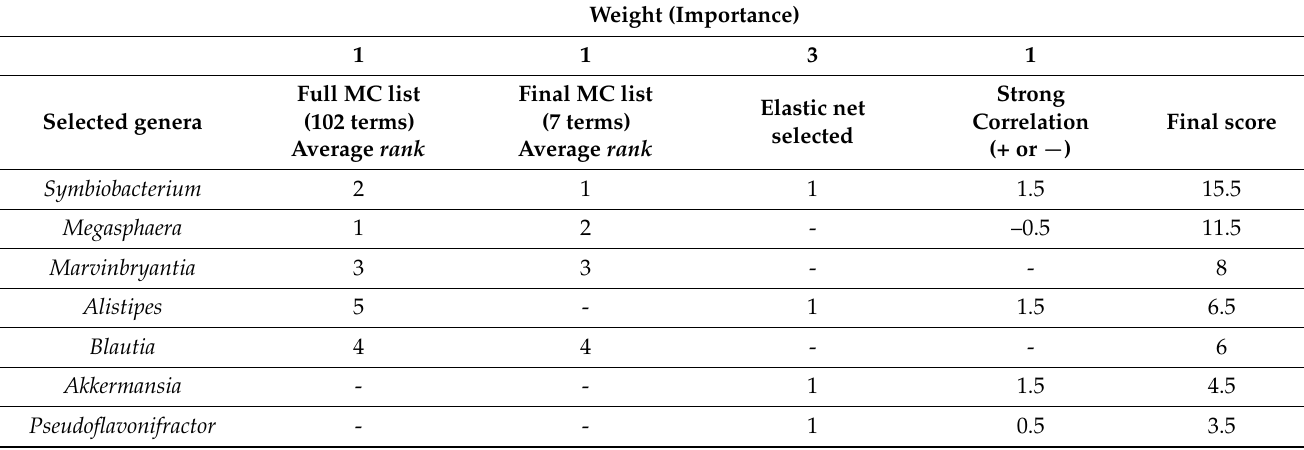
Table 5. Most-relevant candidates on the genera and species level for weight loss success predictor